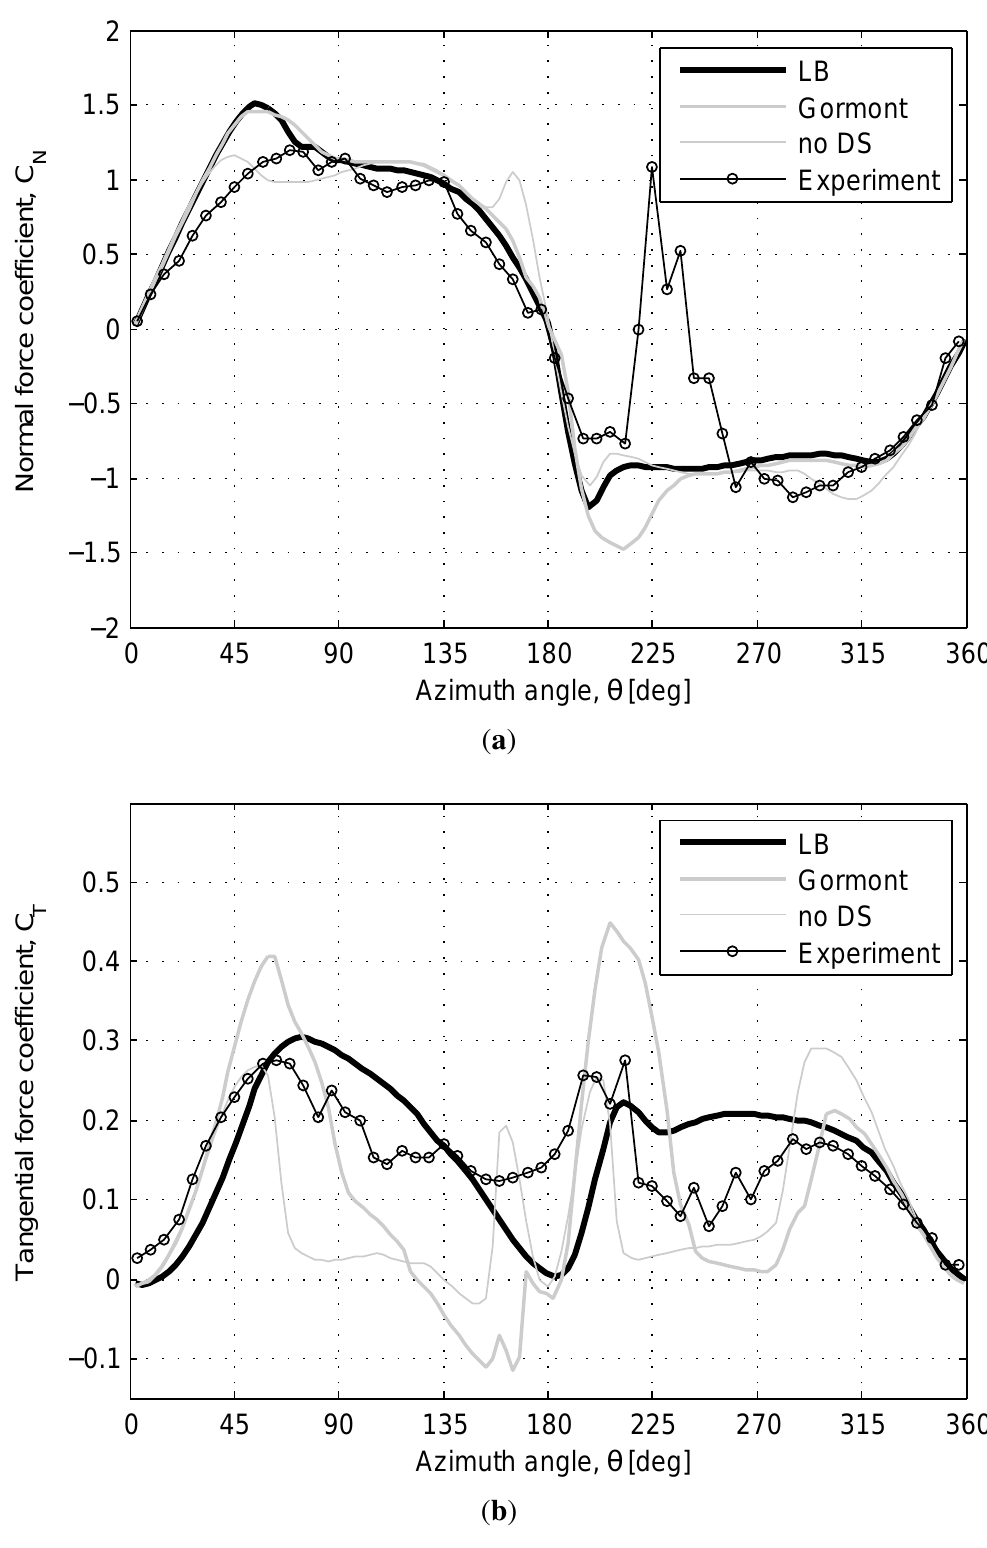
Figure 7. Force response at a tip speed ratio (TSR) of 2.20. ( a ) Normal force; ( b ) tangential